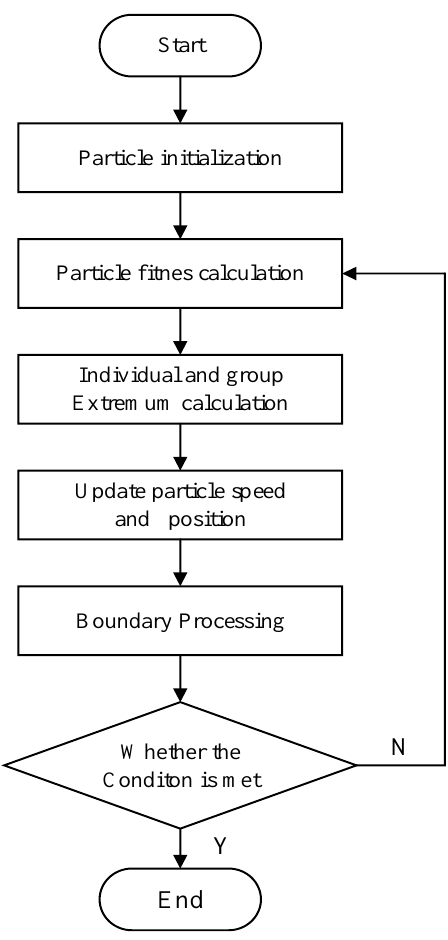
Figure 4. The optimization process of particle swarm optimization. The optimized results of the transfer functions can be passively realized by the elec- trical network involving resistors, capacitors, and inductors. Figure 5 illustrates the corre- sponding network; Table 2 shows the detailed